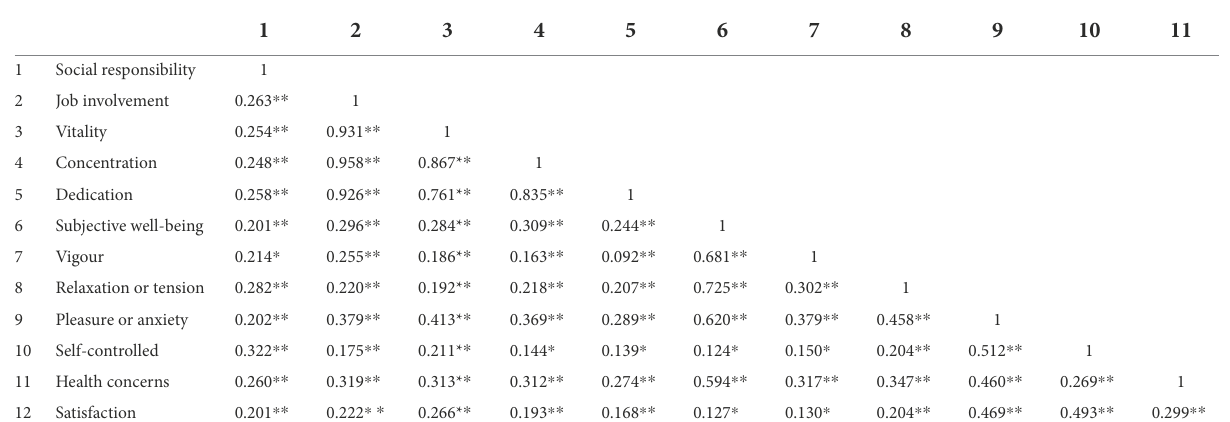
TABLE 2 Correlations among study